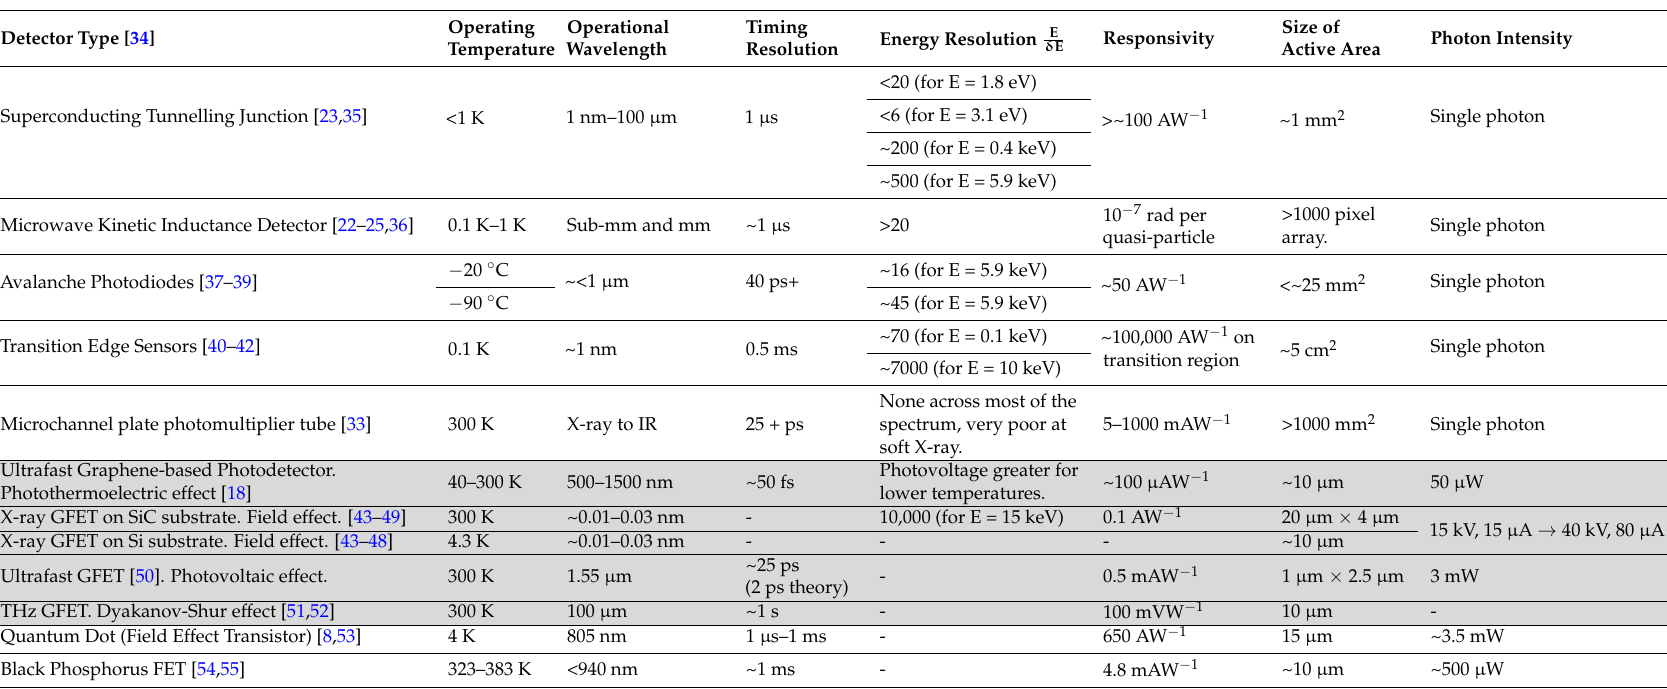
Table 1. Brief summary of a selection of photodetector technologies, with up and coming graphene-based technologies highlighted in grey followed by other potential